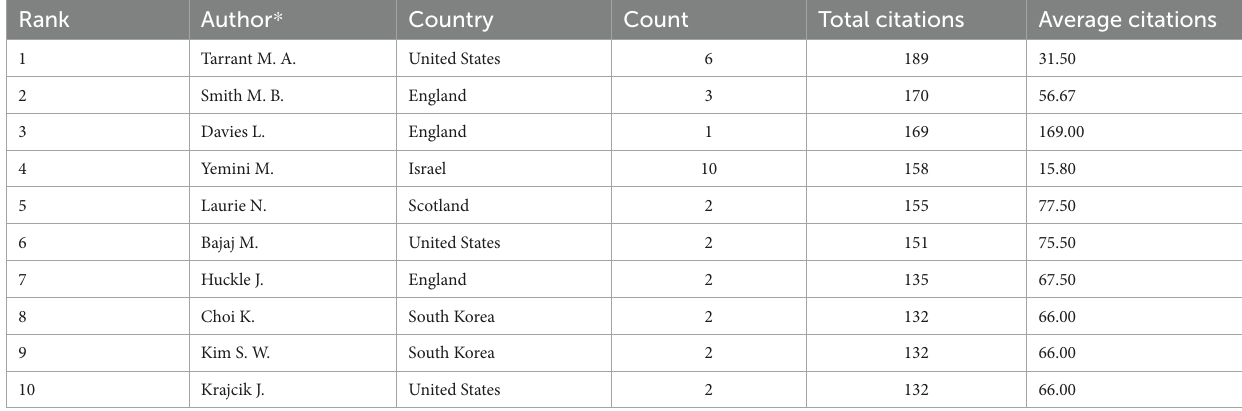
TABLE 3 Rank order of the 10 most cited